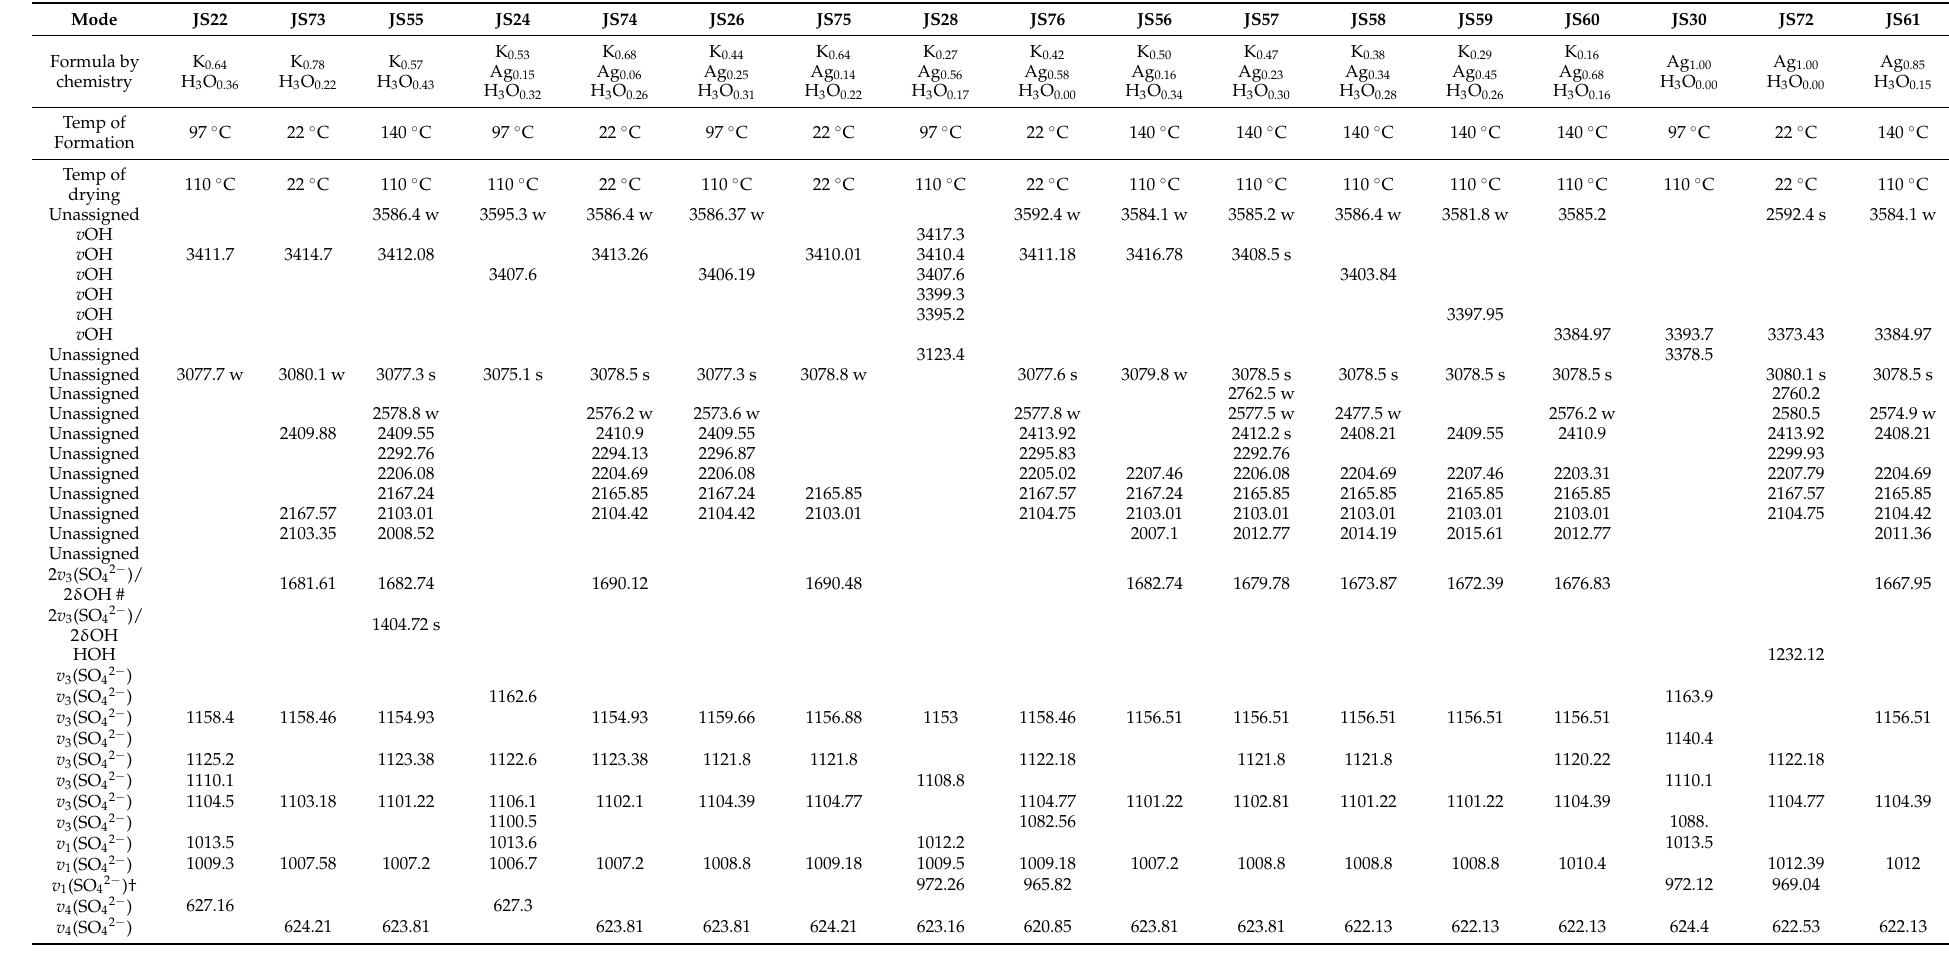
Table 4. Raman frequencies (wavenumber, cm − 1 ) and mode assignment for synthetic K-Ag-H 3 O jarosite compounds. Key: B-O * = B-O (or OH-O, [28]); † = similar peak and assignment reported at http://www.sci.qut.edu.au/sci_schps.html (accessed on 14 February 2016); # assigned to δ (H 2 O) in the mid-IR study of synthetic K-jarosite in Bishop and Murad [24]; s = strong; w = weak; sh = shoulder; b = broad; sp =